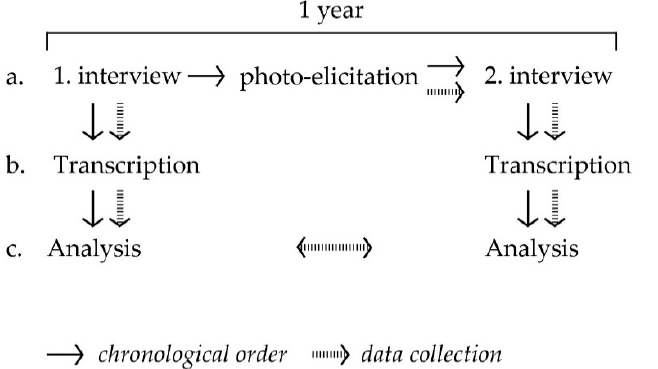
Figure 3. The structure (a, b, c) and the process of the long-term spatial interview with one inter- viewee.